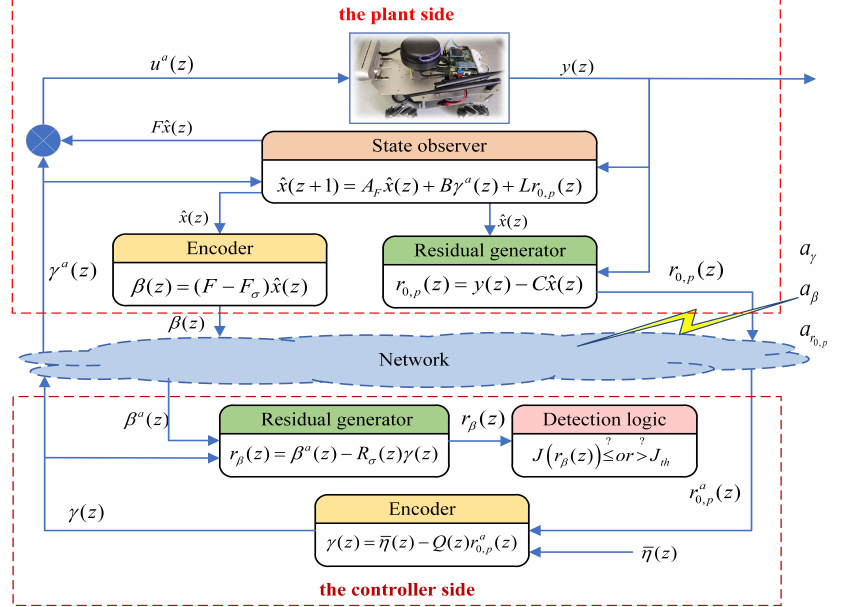
Figure 2. Realization of the improved detection method based on r β ( z )